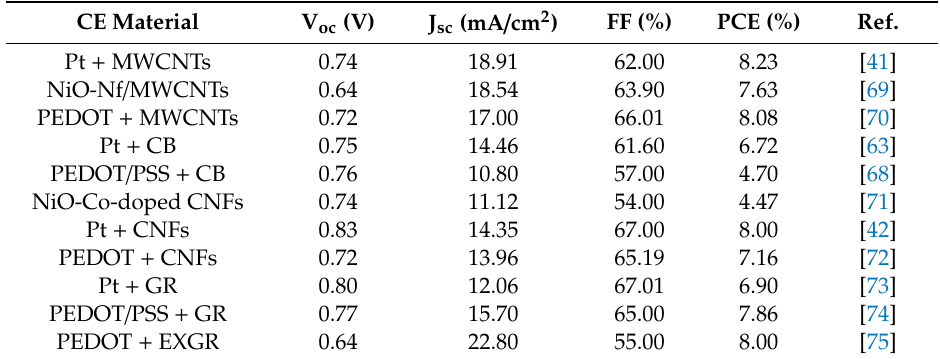
Table 2. Photovoltaic parameters of DSSCs based on high-performance composites with di ff erent metal oxides and PEDOT-based composite